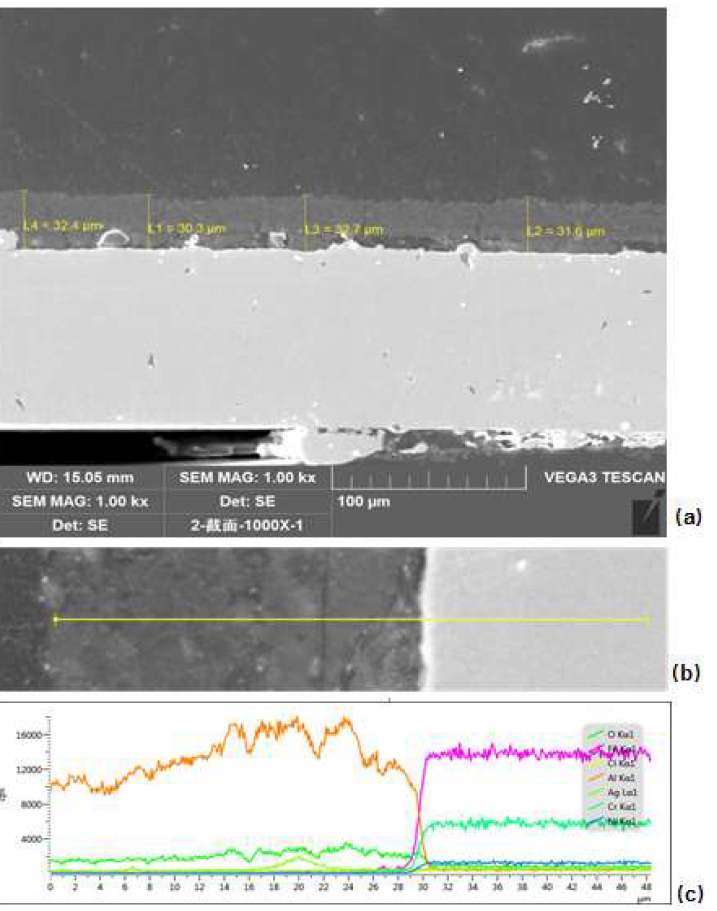
Figure 9. SEM images and EDS linescan spectra of section. ( a ) SEM image of the section of the substrate and coating; ( b ) EDS line scan position; ( c ) EDS spectra of the